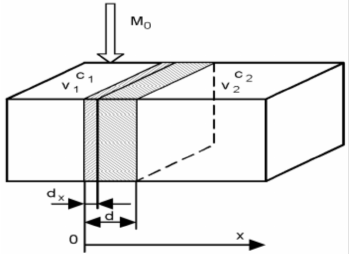
Figure 4. Illustration of the Fick